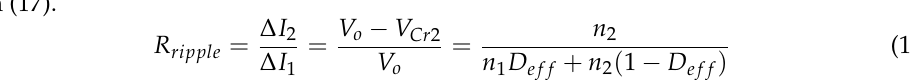
Figure 8. Voltage and current waveforms at the output inductor of the conventional PSFB converter and the proposed converter.